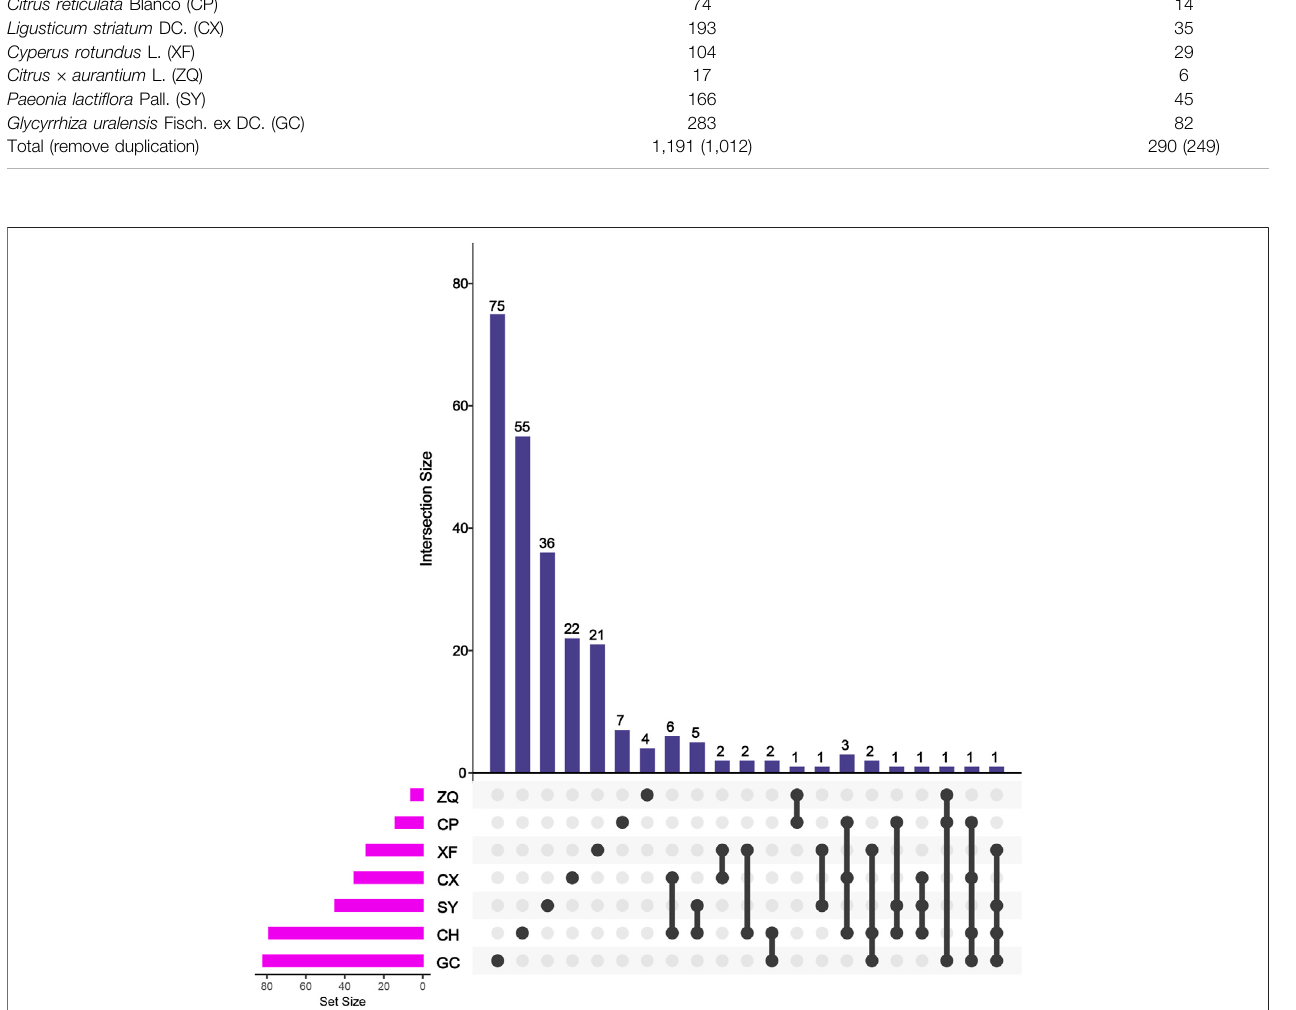
TABLE 2 | The number of components collected in the published databases and active components screened by ADMET models in CHSGS. Botanical drugs #Components #Active components Bupleurum scorzonerifolium Willd. (CH)